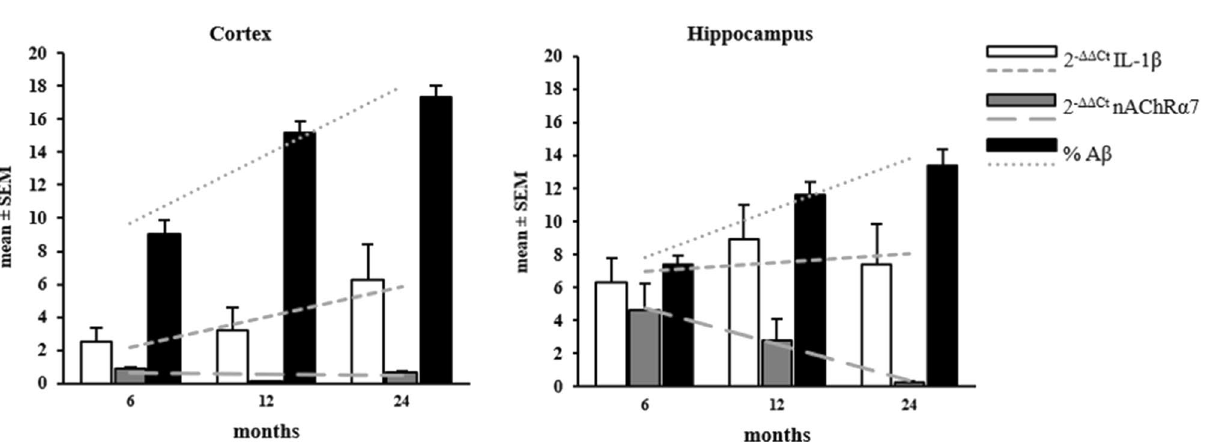
Figure 7. Graphical representation of age-related IL-1β and nAChRα7 expression levels and Aβ deposition in cortex and hippocampus. Bar plots graphically depict the mean and SEM of IL-1β and nAChRα7 gene expression levels and the percentage of Aβ deposition in cortex and hippocampus at different postnatal ages. The trend lines for the same parameters are depicted too with β coefficient ± SEM for IL-1β: 1.8 ± 1.1, for nAChRα7: − 0.1 ± 0.1, and for Aβ: 0.4 ± 0.1 in cortex, and with β coefficient ± SEM for IL-1β: 0.5 ± 1.4, for nAChRα7: − 2.2 ± 0.8, and for Aβ: 0.3 ± 0.1 in